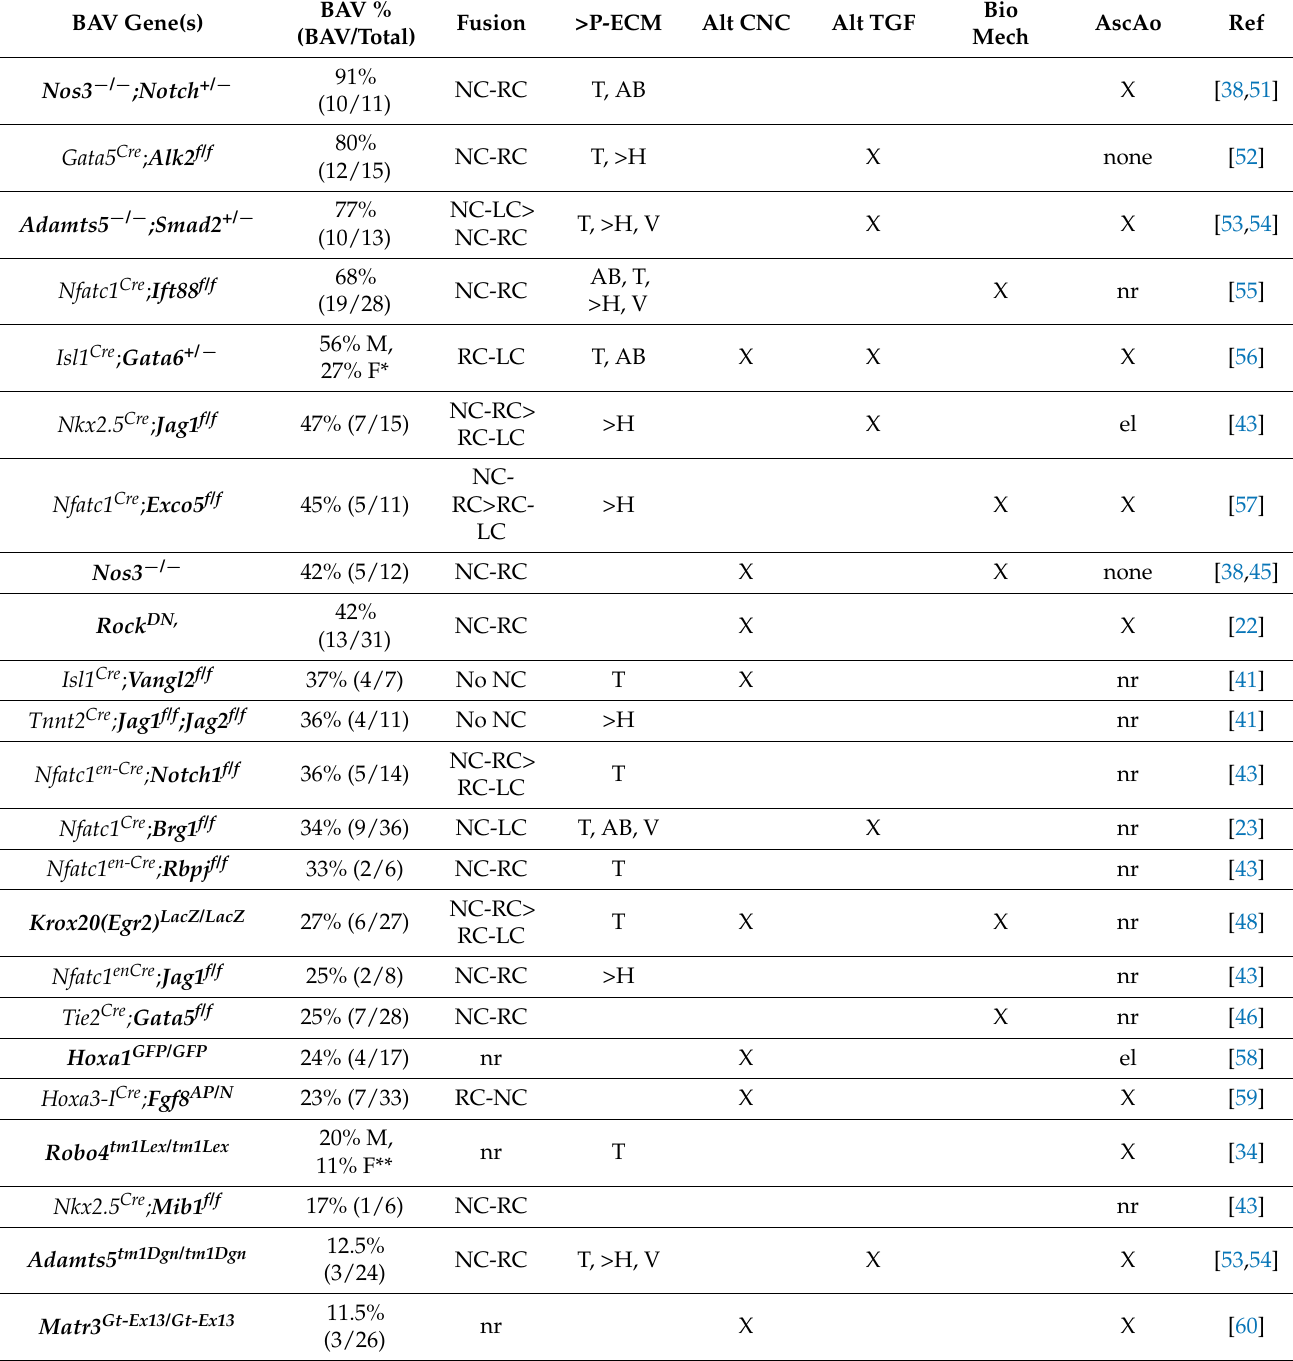
Table 1. Collation of BAV phenotypes in murine models. Gene modifications of mice that exhibit BAVs are listed in order of highest to lowest penetrance of the BAV phenotype, that is, BAV/Total examined. f/f- indicates floxed alleles. The type of BAV fusion events are listed: LC—left coronary cusp; RC—right coronary cusp, NC—non-coronary cusp; nr—not reported. *—56% Males (32/57), 27% Females (7/26); **—20% Males (15/28), 11% Females (12/18). >-P-ECM—excess provisional extracellular matrix is indicated by the following: T—thick valves; AB—increased Alcian blue staining, >H—expanded hinge regions in valve cusps; V—increased immunolocalization of intact Vcan. An X in the alt CNC column indicates altered CNC localization; Alt-TGF β —indicate models with altered TGF β signaling; Biomech—refers to genes that are involved in biomechanical signaling when ‘X’ is present; AscAo—abnormalities in the ascending aorta; el—embryonic lethal; Ref—reference of BAV